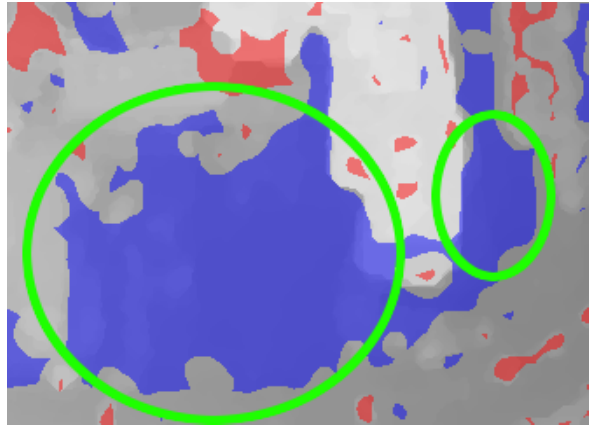
Figure 1: Constructions (blue) and destructions (red) obtained by thresholding a DEM difference map. Two separate constructions (circled in green) are merged by the choice of a low